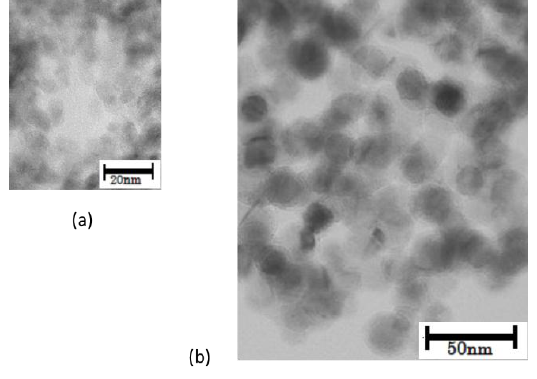
Figure 2. ( a , b ) TEM images of solidified